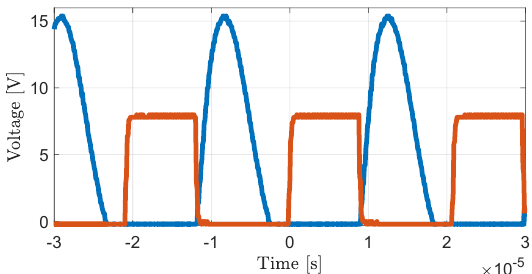
Figure 12. Gate to source and drain to source voltages of the forward converter MOSFET Q1.